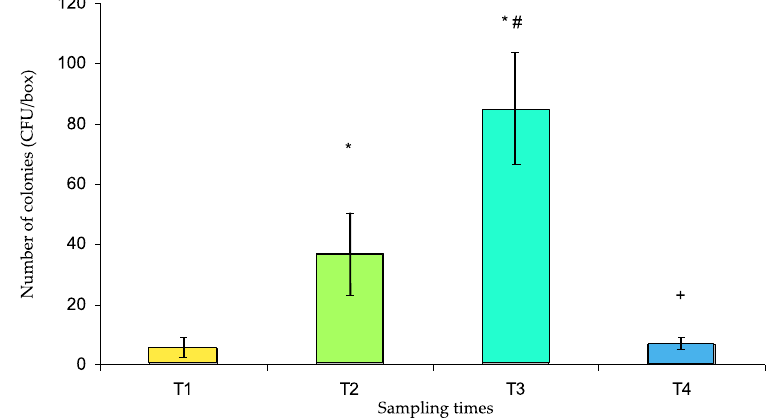
Figure 3. Number of colony forming units (CFUs) per box (mean ± s.e.m.) at different sampling times (T1 to T4). T1: after cleaning, T2: after use for medicine preparation in the pharmacy, T3: upon return from the medical unit, T4: after washing in the dishwasher. * p < 0.001 vs. T1, # p < 0.001 vs. T2, + p < 0.001 vs. T3.